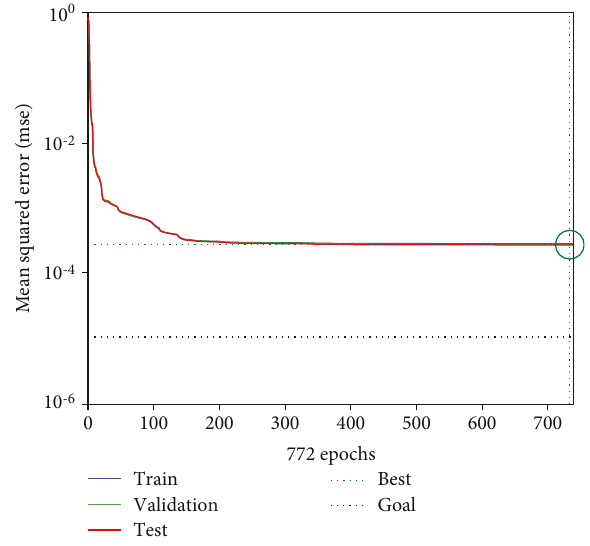
Figure 4: The training curve of the BP neural